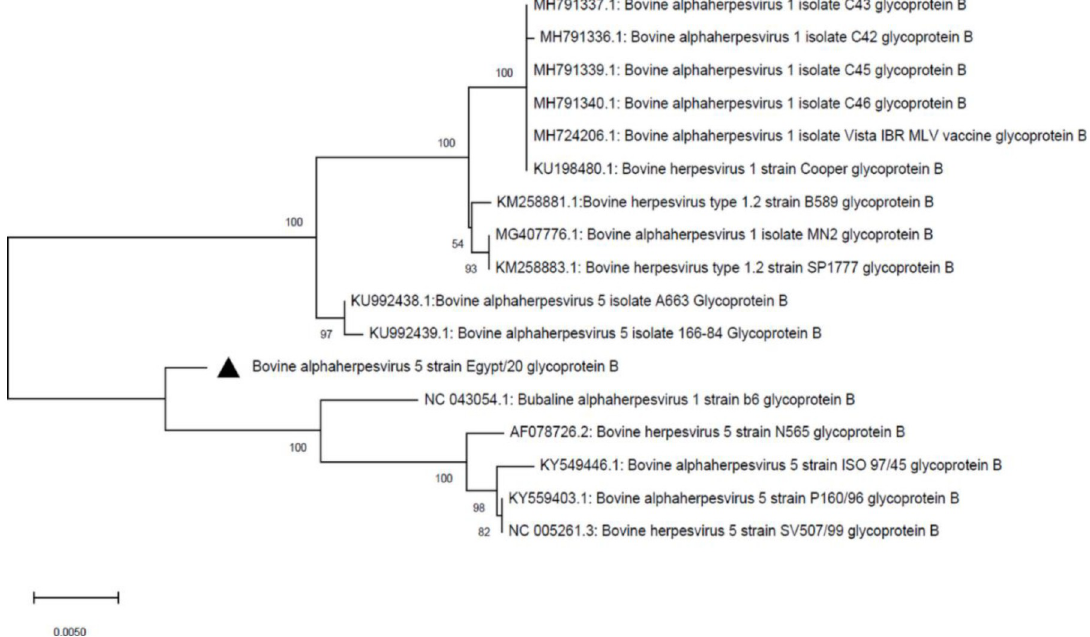
Fig 3. Phylogenetic analysis of BHV-5 gB. The evolutionary history was inferred using the neighbor-joining method [20]. The percentages of replicate trees in which the associated taxa clustered together in the bootstrap test (1000 replicates) are shown next to the branches [21]. The evolutionary distances were computed using the maximum composite likelihood method [22] and are shown as the number of base substitutions per site. The codon positions included were 1 st + 2 nd + 3 rd + Noncoding. Evolutionary analyses were conducted in MEGA X [19]. Different identical sequences were included to increase the robustness of the constructed tree.